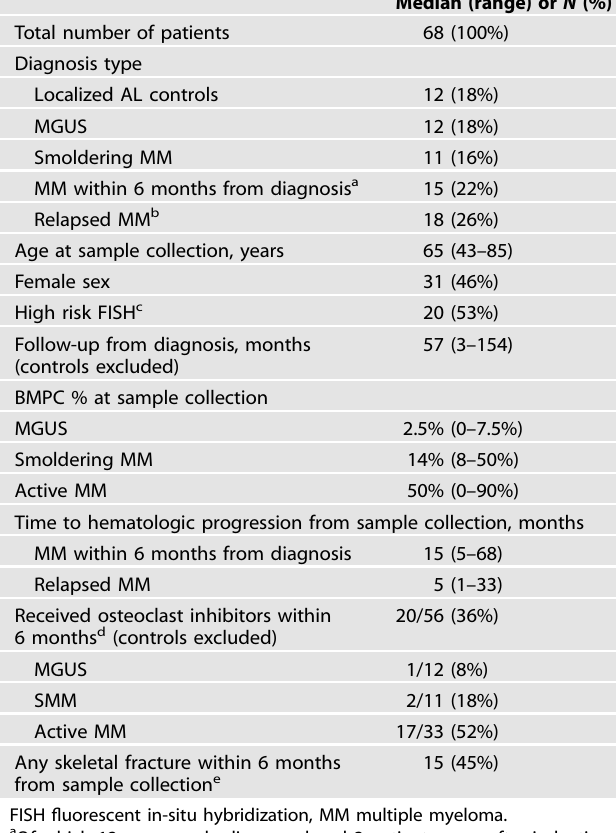
Table 1. Baseline characteristics of